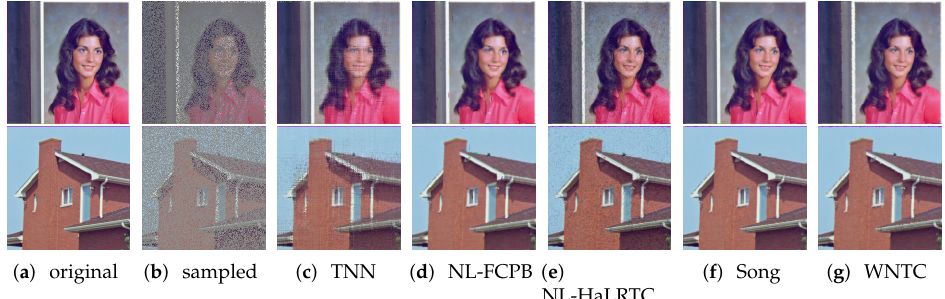
Figure 5. Recovery results of different algorithms on Woman and House images when sampling rate is